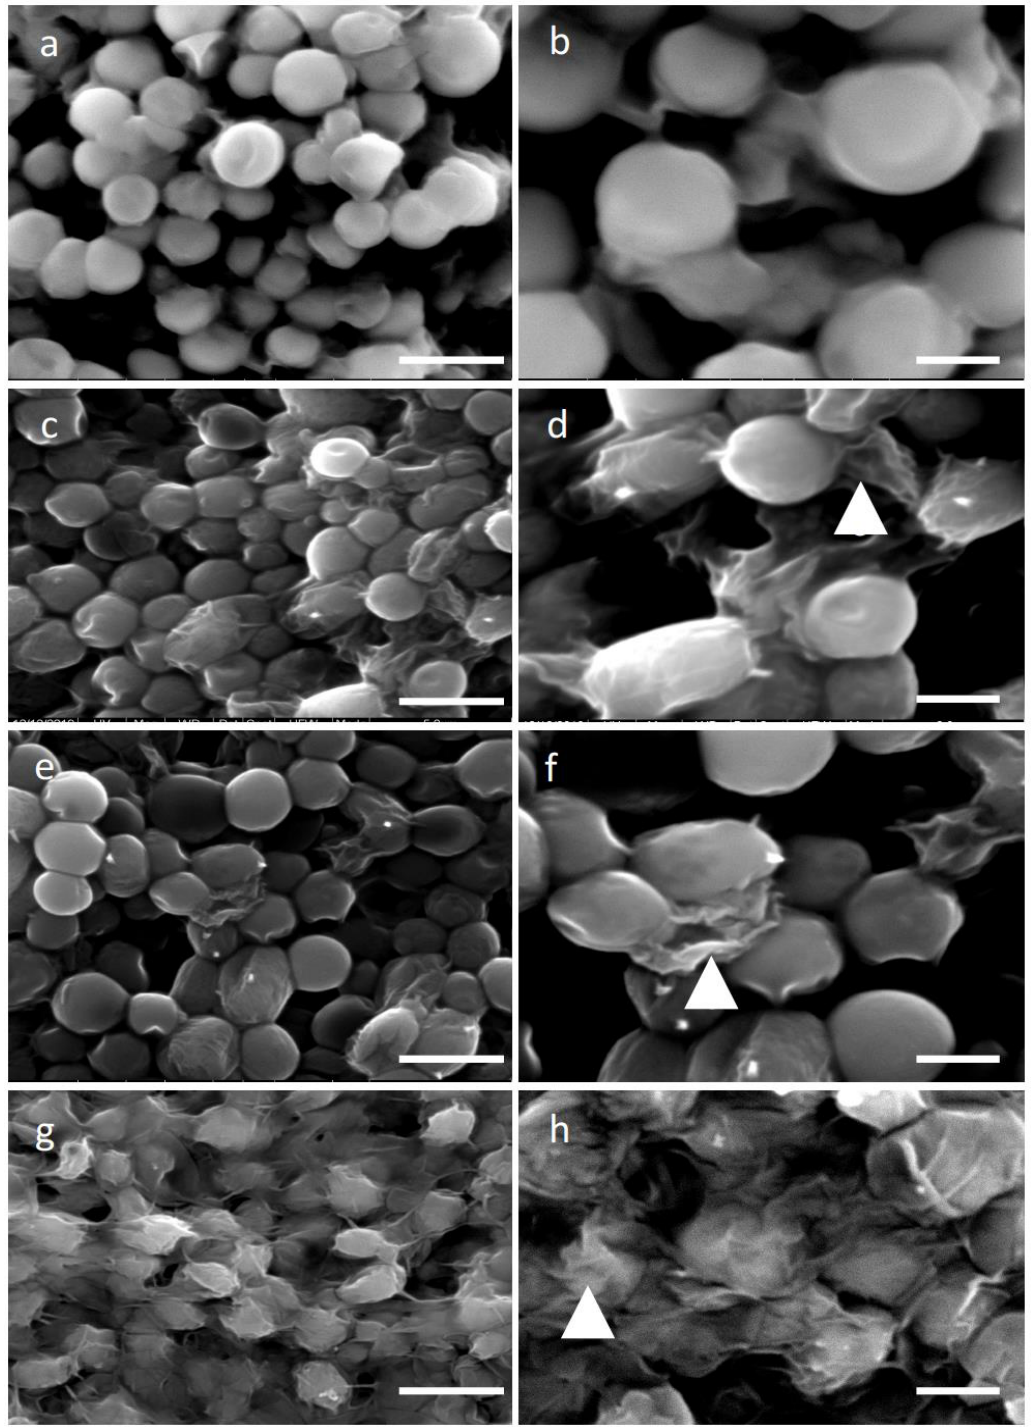
Figure 1. Scanning electron microscopy images of H. pluvialis cells before and after enzymatic/mechanical treatment, in two different magnifications (5000× left column, 10,000× right column) ( a , b ) SEM images of H. pluvialis cells with no treatment (control); ( c , d ) SEM images of H. pluvialis cell wall disruption with 4 h of enzymatic hydrolysis; ( e , f ) SEM images of H. pluvialis cell wall disruption with 16 h of enzymatic hydrolysis; ( g , h ) SEM images of H. pluvialis cell wall disruption after mechanical treatment with glass beads. Scale bars: 5 µm left column, 2 µm right column. White arrows in ( d , f , h ) indicate cell wall fragments.